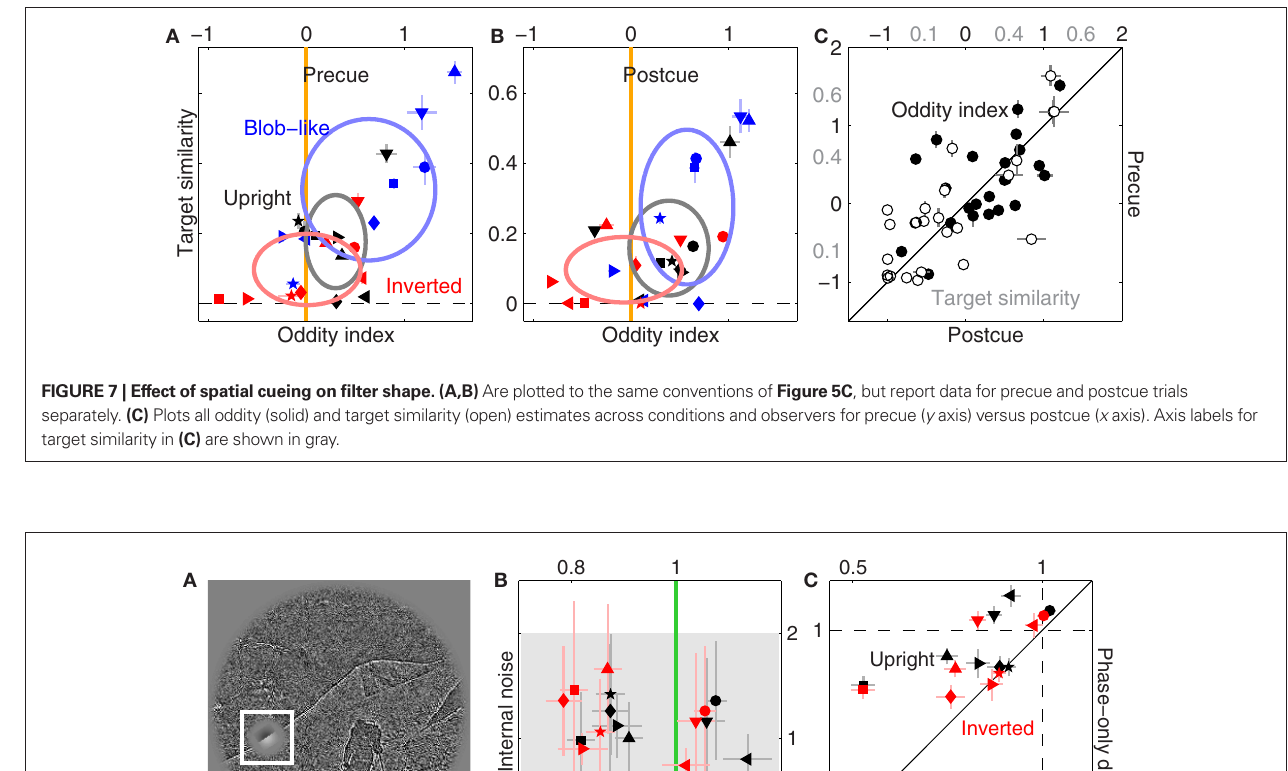
Figure 9A plots the sensitivity ratio between phase-only values and original image values, separately for precue trials on the y axis versus postcue trials on the x axis. On postcue trials, all ratios are > 1 [data points fall to the right of the vertical dashed line at p < 0.02 for upright (black) condition and p < 0.03 for inverted (red) condi- tion]. This effect is not significant for precue trials: ratios are > 1 (data points fall on the horizontal dashed line at p > 0.05 for both